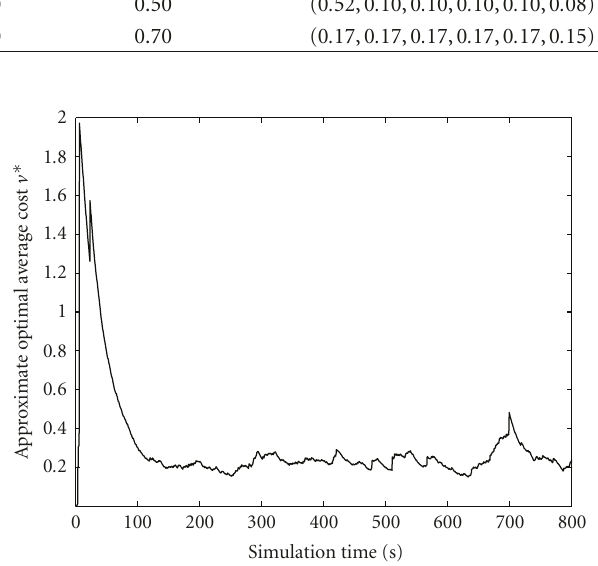
Figure 5: Curve of (cid:12) v under large step size